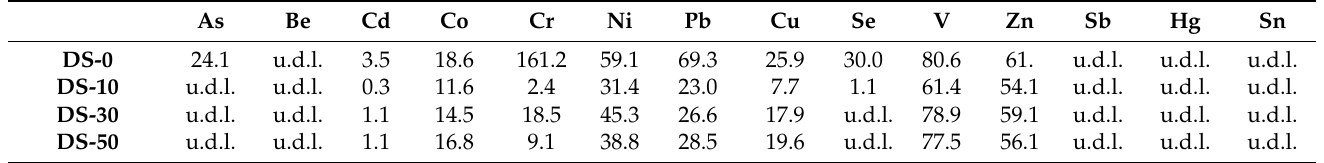
Table 5. Minor chemical components (in ppm) in brick mixtures.